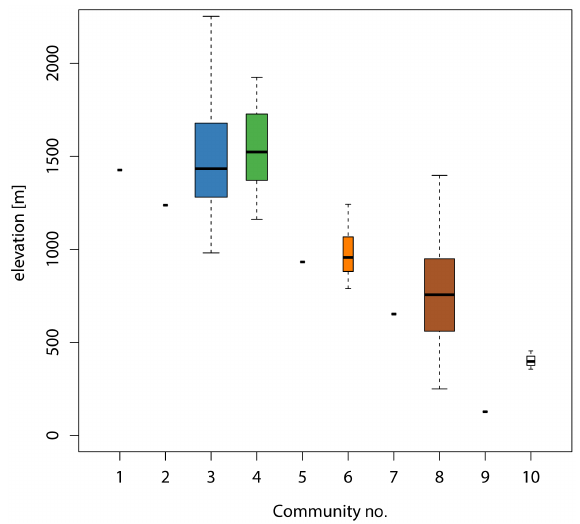
Figure 10. Boxplots of mean basin elevation grouped by commu- nity. The colours are consistent with the map in Fig. 8.